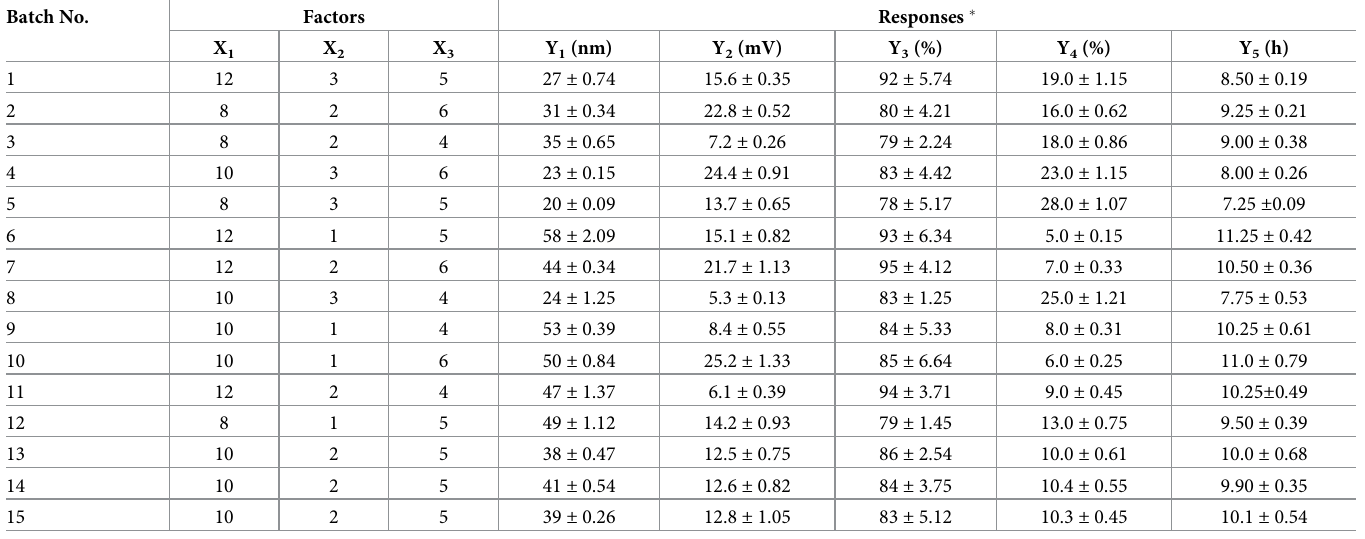
Table 1. Design matrix including investigated factors with their levels and the observed values of responses (Y 1 - Y 5 ) for 15 formulations of carvedilol-loaded solid lipid nanoparticles. Batch